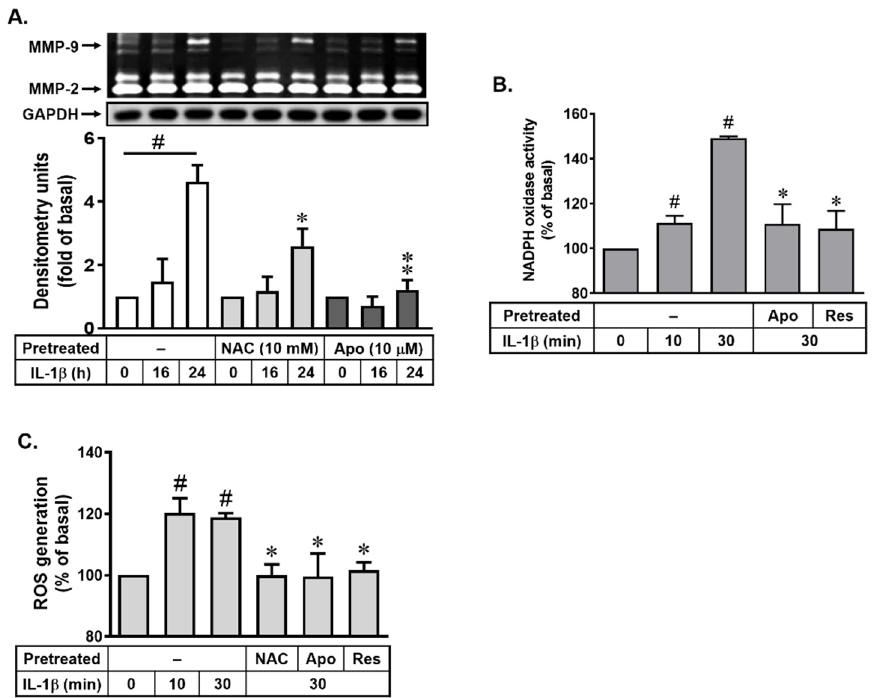
Figure 2. Roles of resveratrol in IL-1 β -induced MMP-9 expression via Nox-mediated ROS generation. ( A ) The Nox/ROS system inhibitors blocked IL-1 β -induced MMP-9 expression; cells were pretreated with NAC (10 mM) or apocynin (Apo, 10 µ M) and then incubated with IL-1 β (10 ng/mL) for 0, 16, and 24 h. ( B ) IL-1 β stimulates Nox activity increase. Cells were pretreated without or with Apo (10 µ M) or Res (1 µ M) for 1 h before exposure to IL-1 β (10 ng/mL) for the indicated times. ( C ) IL-1 β stimulates Nox-mediated ROS generation. Cells were pretreated without or with NAC (10 mM), Apo (10 µ M), or Res (1 µ M) for 1 h before exposure to IL-1 β (10 ng/mL) for the indicated times. The conditioned media were collected and analyzed as described in Figure 1A. The Nox activity ( B ) and ROS generation ( C ) were analyzed, as described in Methods. Quantitative data were analyzed by one-way ANOVA, as described in Methods. Data are expressed as the mean ± SEM ( n = 3); # p < 0.01, as compared with the untreated control; * p < 0.05; ** p < 0.01, as compared with the cells stimulated with IL-1 β only. The image represents one of three individual